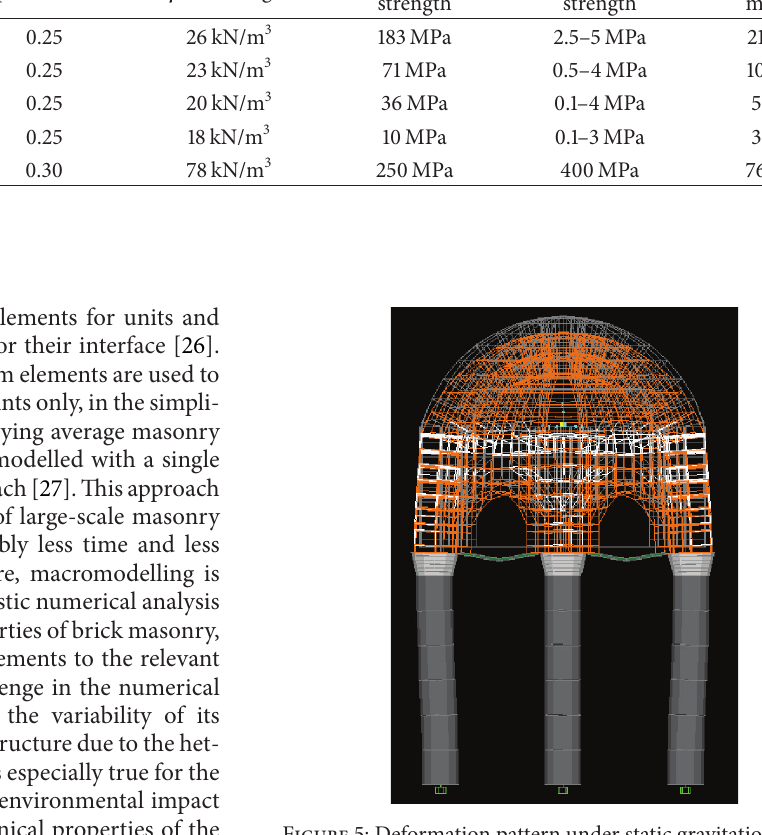
Figure 5: Deformation pattern under static gravitational